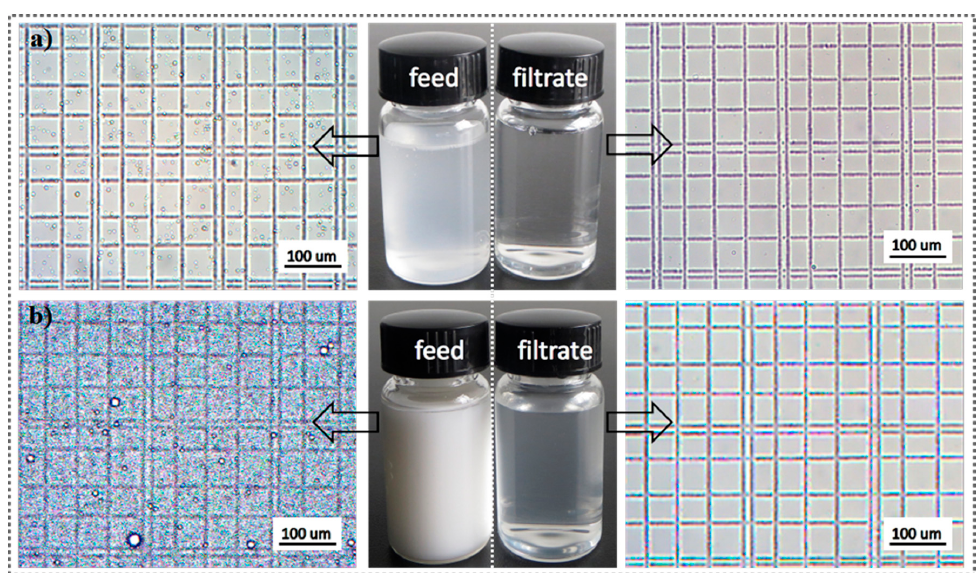
Figure 6. Separation results for various oil-in-water emulsions: ( a ) surfactant-free H/W ( n -hexane-in- water) emulsion and ( b ) D/W (diesel-in-water)